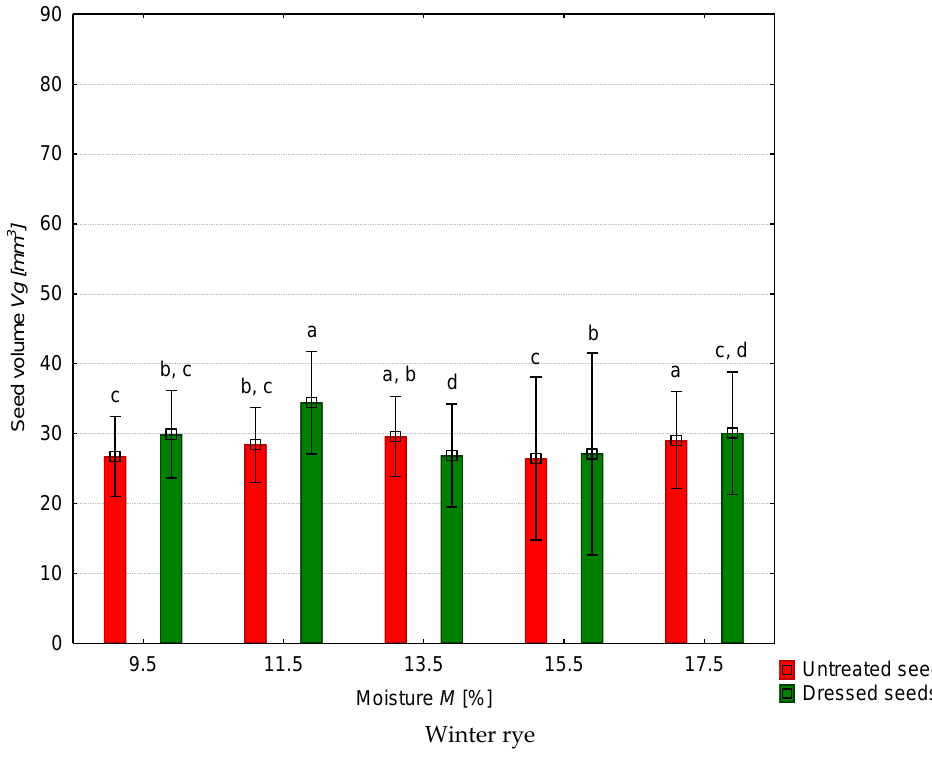
Figure 6. The volume of the dressed and untreated winter triticale, barley, and rye seeds. Note: a, b, c, d—different letters indicate significant differences at p < 0.05 in the group of dressed and untreated seeds (Duncan’s test).